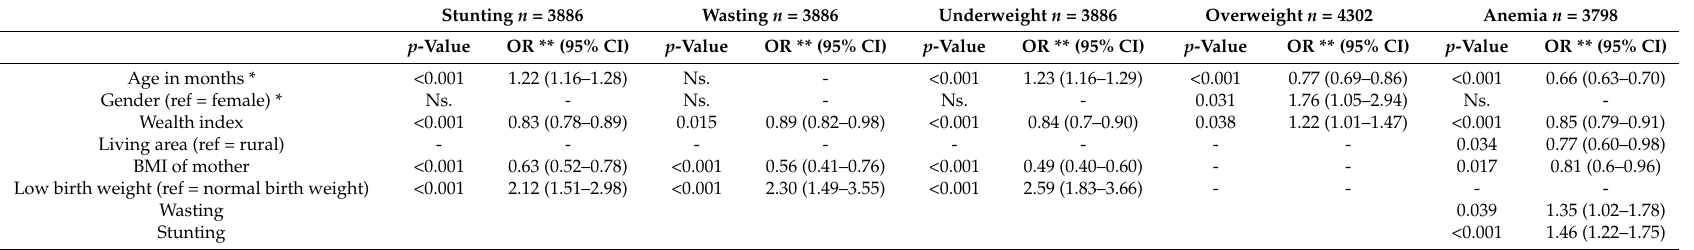
Table 7. p -values and odds ratio of contributing factors to stunting, wasting, overweight, and anemia in the 2014 DHS